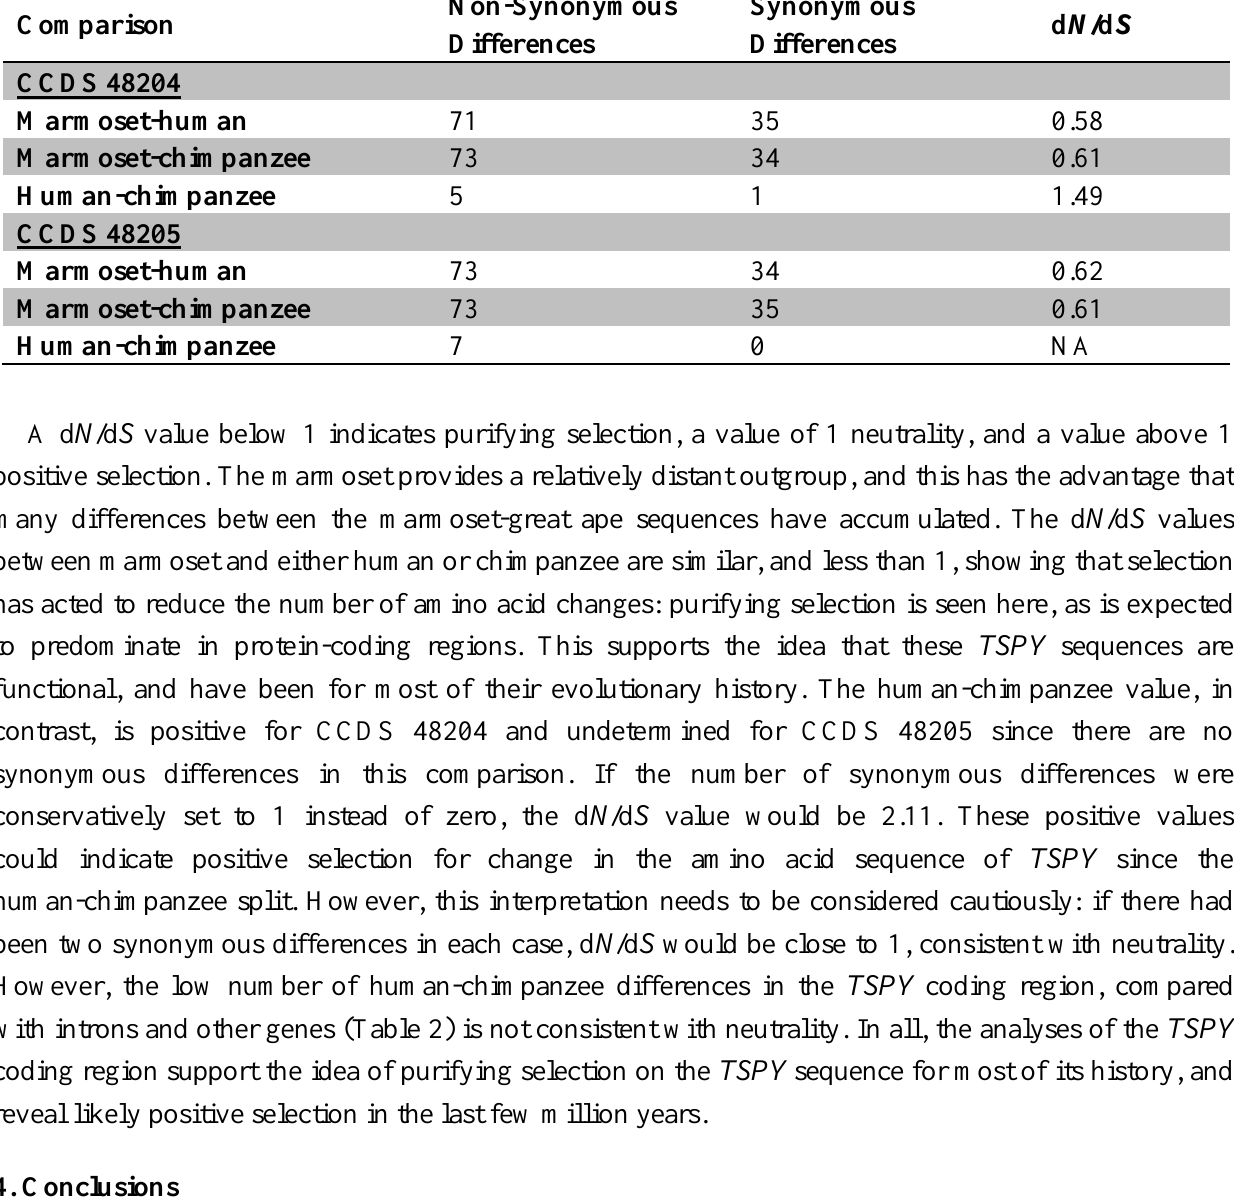
Table 3. Selective forces on the TSPY amino acid sequence assessed using the d N /d S statistic.